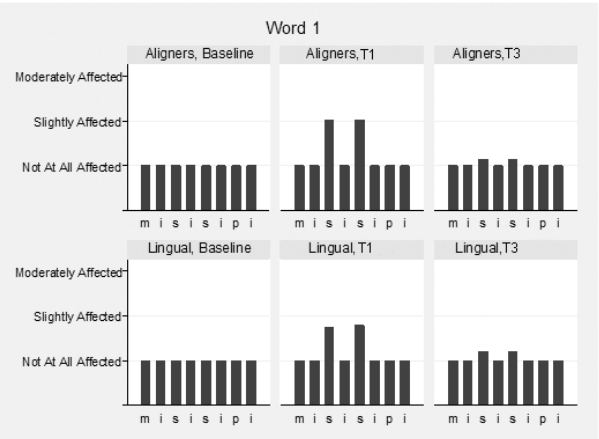
Figure 4. Speech articulation (1st word: “Mississippi”) by group and time (T1, baseline; T2, immediately following appliance insertion; and T3, after 3 months).